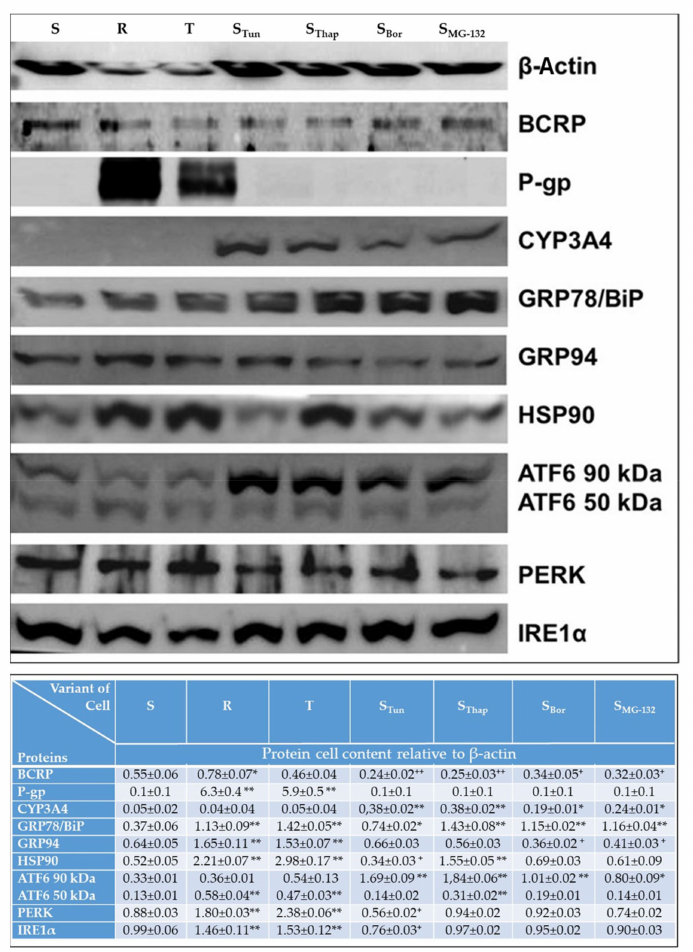
Figure 5. Western blot detection of cellular breast cancer resistance protein (BCRP), P-gp, CYP3A13 (detected by an antibody against its human ortholog, CYP3A4), GRP78 / BiP, GRP94, HSP90, ATF6 (both the 90 and 50 kDa variants, PERK and IRE1 α ) levels. β -Actin was used as a control protein. Protein bands were quantified by densitometry, and data were normalized to β -actin cell content and are expressed as the mean ± S.E.M. of at least three independent measurements. Significance: